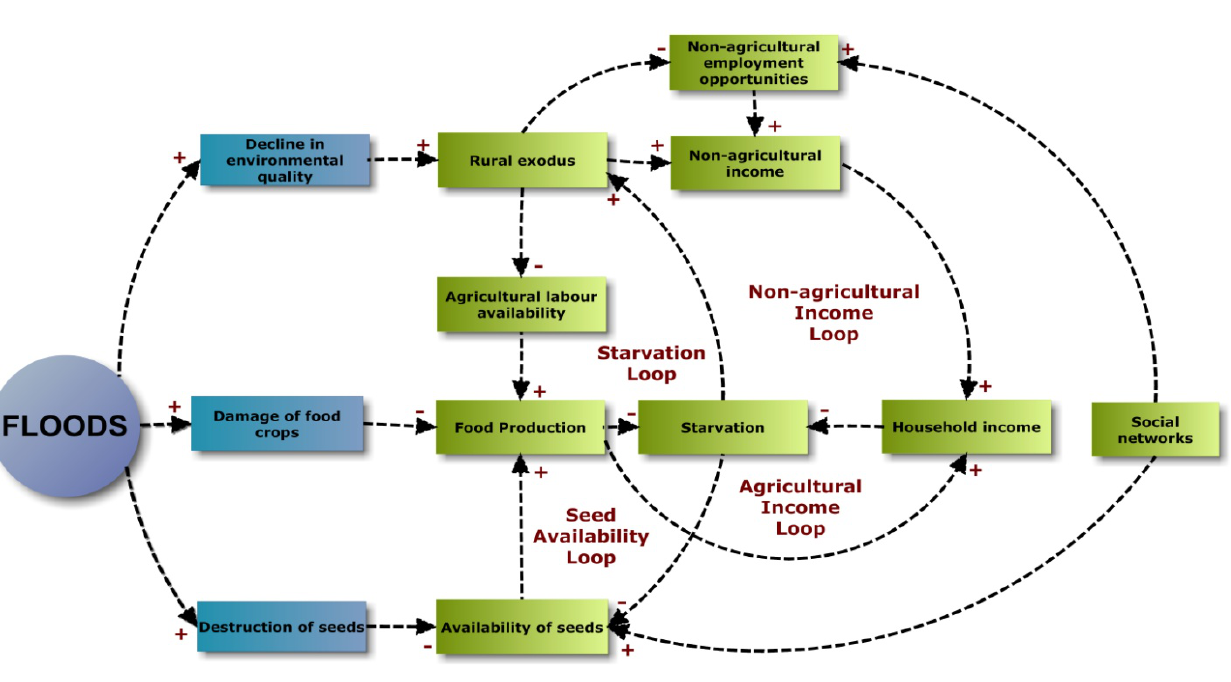
Figure 1. A simplified causal loop diagram illustrating the impact of floods on communities in Northern